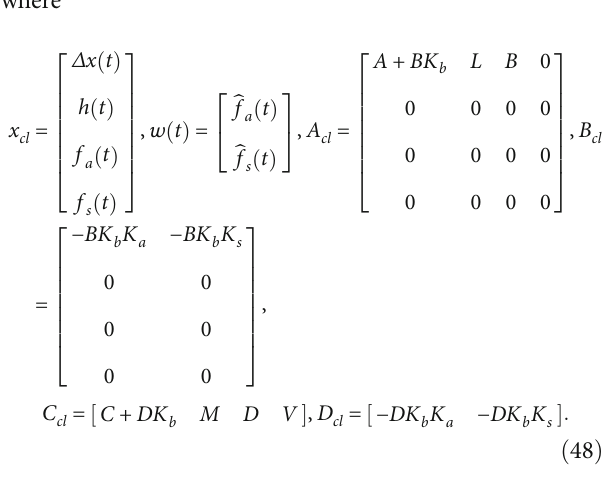
Figure 13: The fuel supply system and electric control cabinet in the platform (it is reproduced from